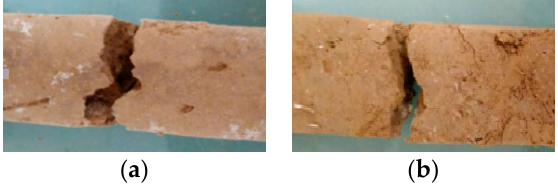
Figure 13. The serrated failure: ( a ) low water content; ( b ) high water content.